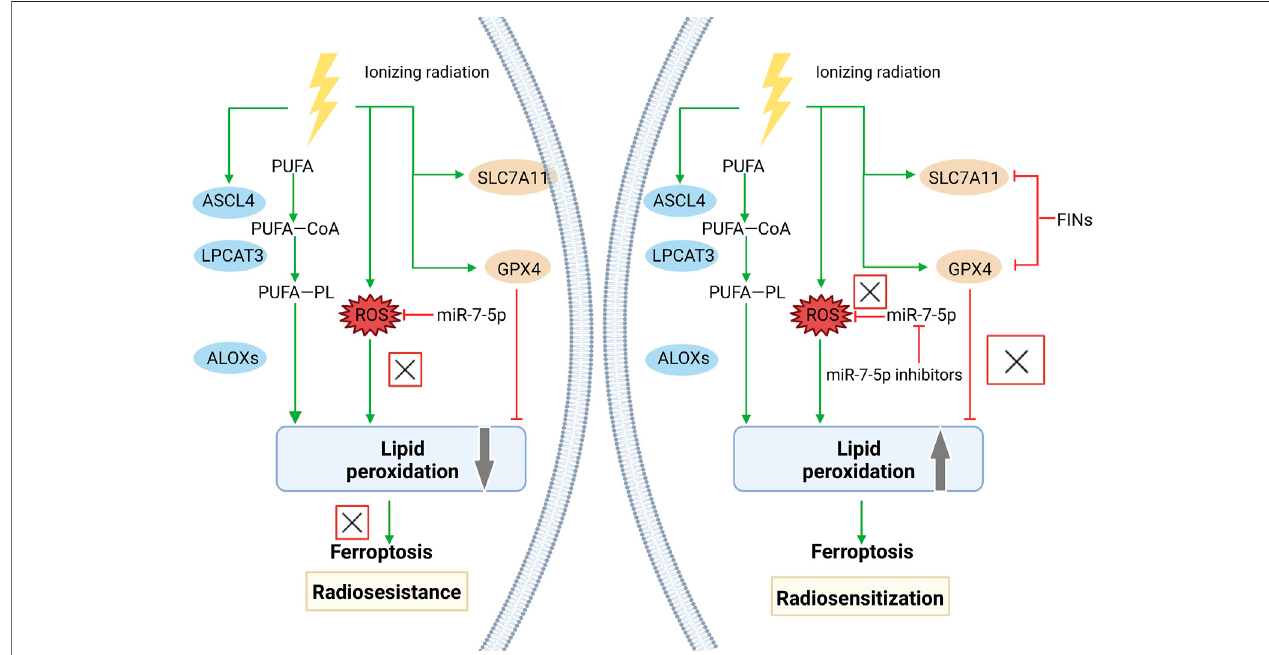
FIGURE 3 | Reversal of radioresistance by targeting ferroptosis. Radioresistance remains a major factor in radiotherapy failure. Radiation therapy can lead to the production of massive ROS and upregulate the expression of ACSL4, promote lipid peroxidation and eventually cause ferroptosis. However, radiotherapy also induced an adaptive response in tumor cells. The expression of ferroptosis suppressors, including SLC7A11 and GPX4, was also signi fi cantly upregulated, which promoted cancer cell survival and radioresistance after radiotherapy. FINs that inhibit SLC7A11 or GPX4 can enhance the sensitivity of radioresistant cancer cells to IR- induced ferroptosis and reverse radioresistance. miR-7-5p controls radioresistance via ROS generation that leads to ferroptosis. Knockdown of miR-7-5p increased ROS and reversed